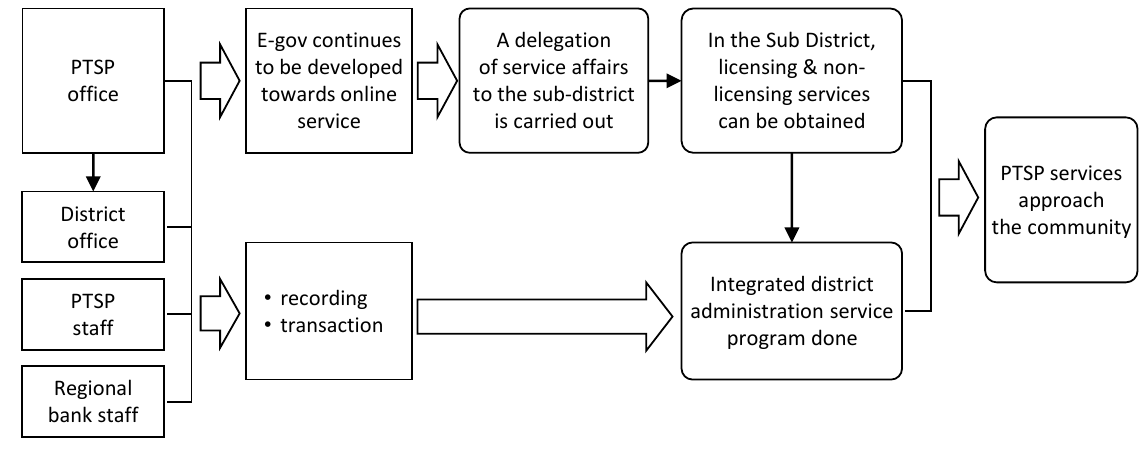
Figure 3. Super service delivery conceptual